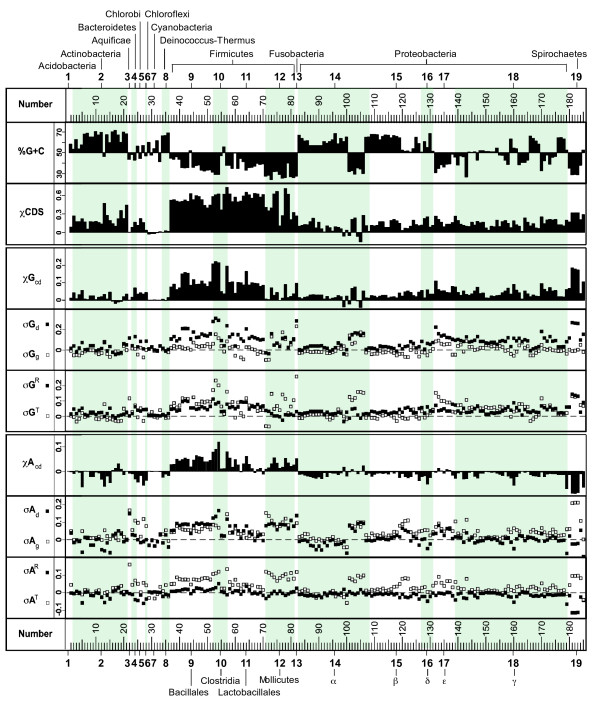
The various genomic parameters relevant to the base composition skews of the bacterial chromosomes. The bacteria are arranged in Genus (top) and Groups (1–19, Figure 1; shaded), and numbered [see Additional file 1 for complete list]. (Top panel) G+C contents and χCDS. (Middle panel) χGcd, σGd, σGg, σGR, and σGT. (Bottom panel) χAcd, σAd, σAg, σAR, and σAT. Filled squares are for the leading strands, and open squares are for lagging strands.